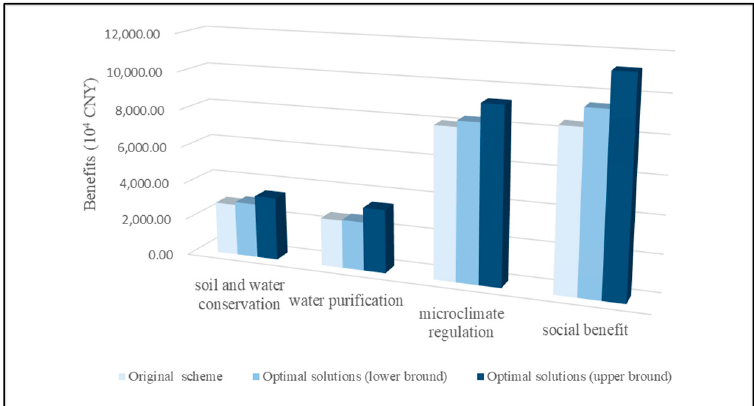
Figure 3. The ecological and social benefits for the recommended scheme and the optimal solutions.